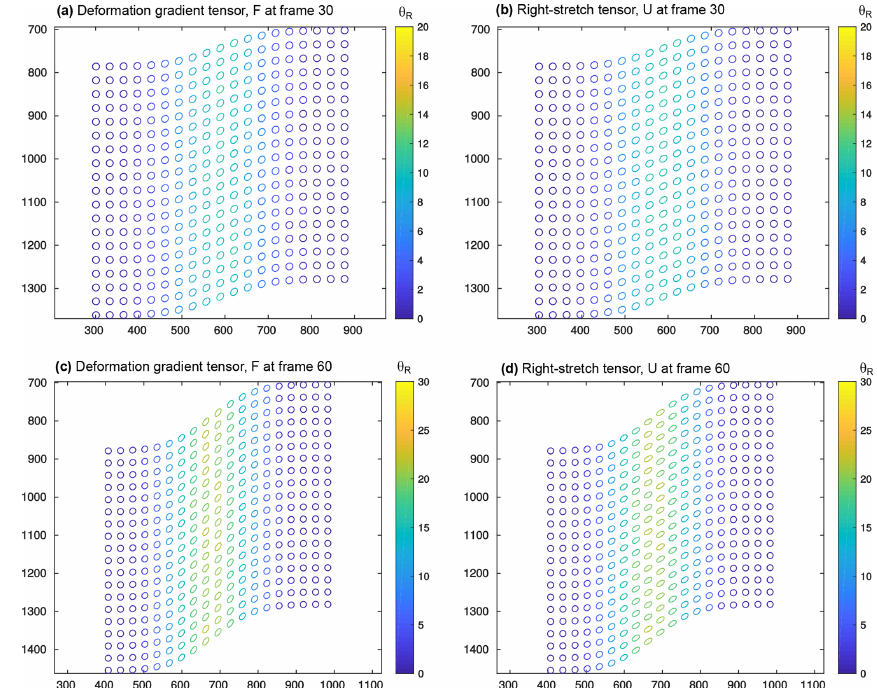
Figure 12. Deformation gradient tensor F and right-stretch tensor U calculated from the Lagrangian sum of displacements at frame 30 and 60 of the moving shear zone synthetic test. For clarity, only one in four points is plotted as an ellipse. The colour indicates the amount of finite rigid-body rotation obtained via tensor R (in degrees anticlockwise). Positions of the plotted areas are indicated in Fig.